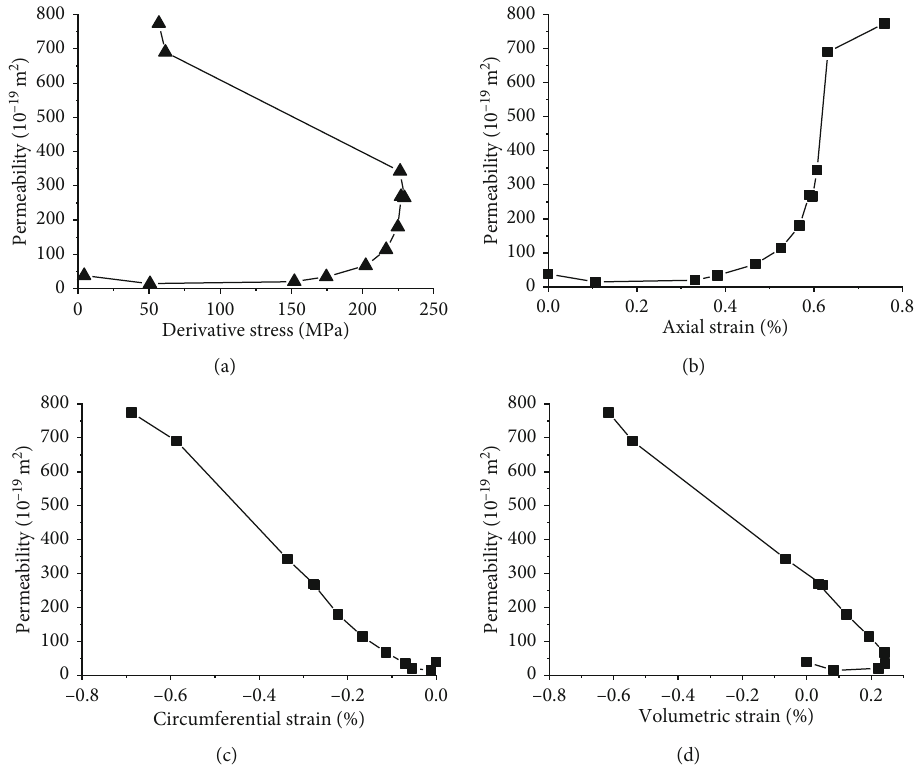
Figure 3: Measured permeability versus (a) derivative stress, (b) axial strain, (c) circumferential strain, and (d) volumetric